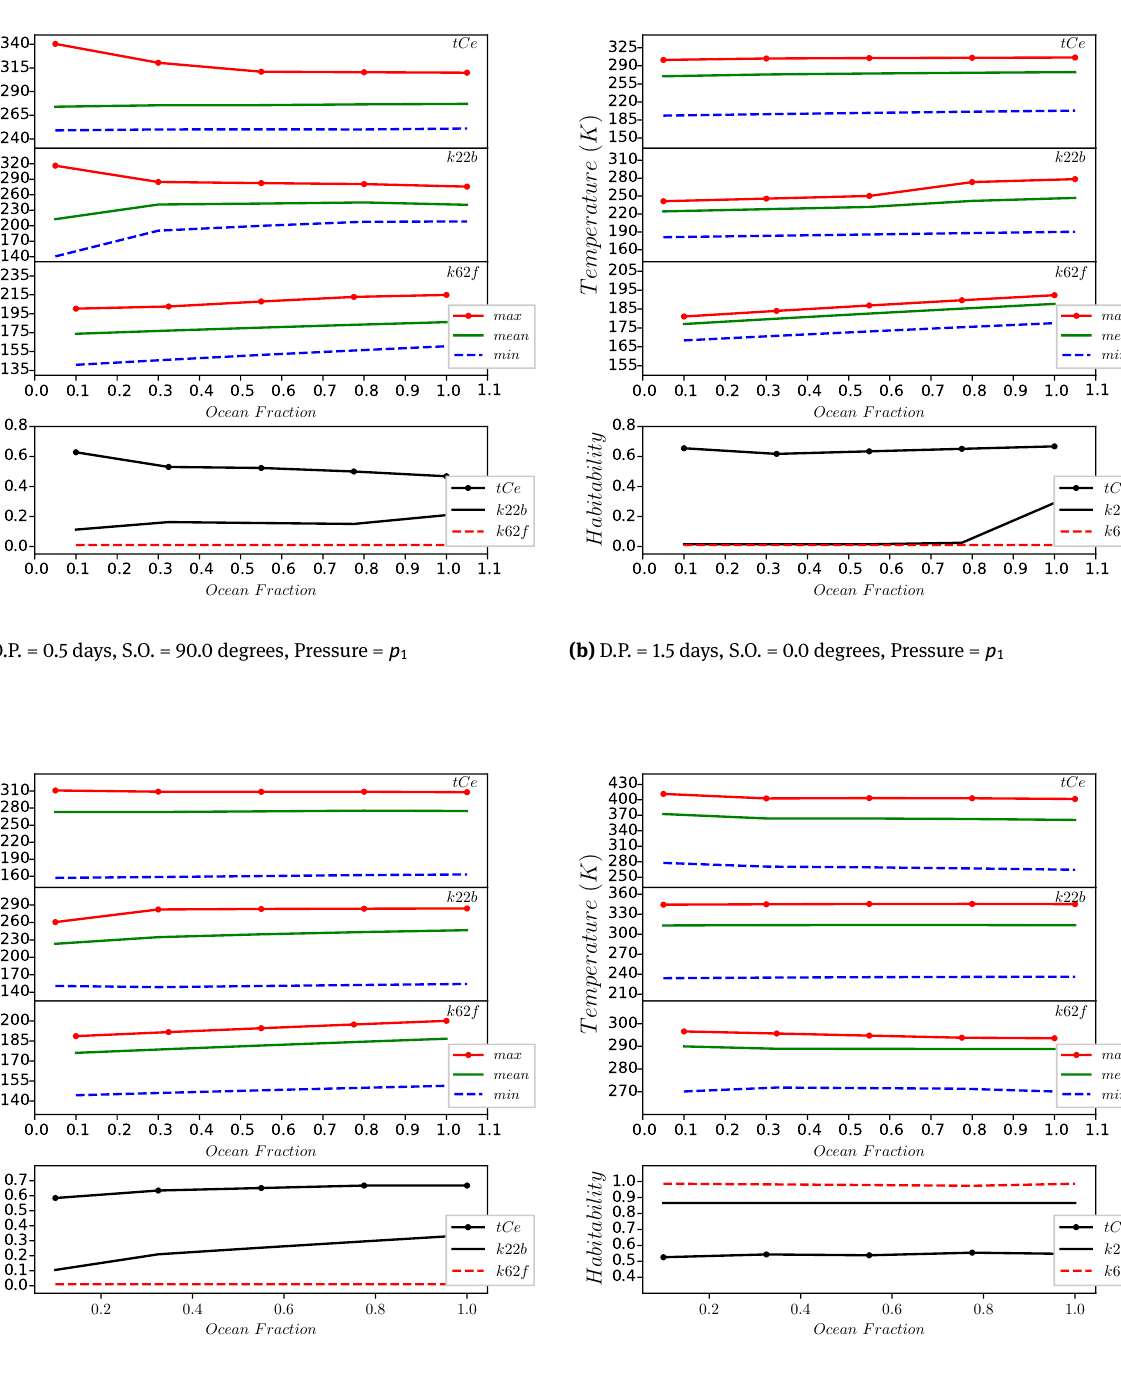
(c) D.P. = 0.5 days, S.O. = 0.0 degrees, Pressure = p 1 (d) D.P. = 0.5 days, S.O. = 0.0 degrees, Pressure = p 5 Figure 2. Ocean fraction varies; for planet τ Ceti e (tCe), Kepler-22b (k22b), p 1 = 0.1 atm , p 5 = 1.3 atm ; and for Kepler-62f (k62f) p 1 = 0.5 atm , p 5 = 4.5 atm